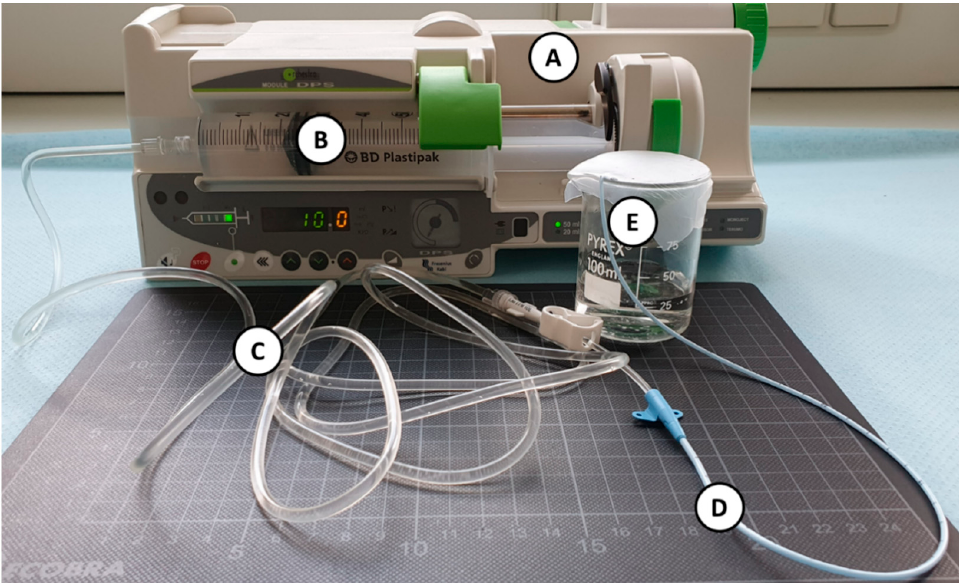
Figure 1. Picture of the experimental setup in dynamic condition ( A ): electric syringe pump; ( B ): 50 mL syringe; ( C ): extension set tubing; ( D ): catheter; ( E ): sampling site at the end of the infusion line).